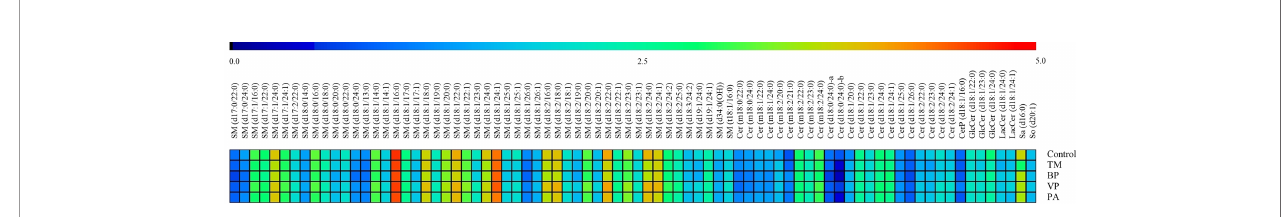
FIGURE 1 | Heat map showing level of each serum sphingolipid (SPL) in healthy controls (Control) ( n = 26), patients with T. marneffei infection (TM) ( n = 32), patients with bacterial pneumonia (BP) ( n = 10), patients with viral pneumonia (VP) ( n = 4), and patients with pulmonary aspergillosis (PA) ( n = 20). For each SPL, the mean concentrations within different groups were log 10 transformed. The color legend ranges from blue to red indicating low to high